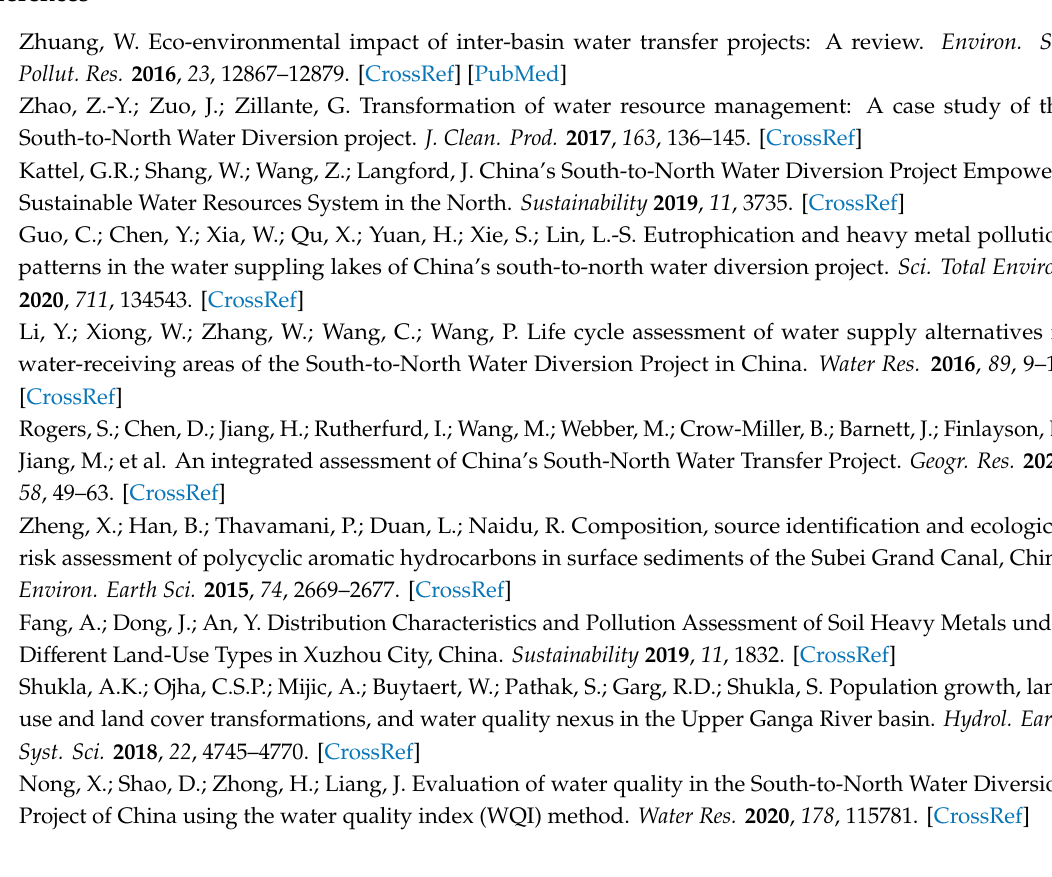
Table S1: The standard values for each class of the five main water quality parameters according to China’s Environmental Quality Standard for Surface Water (GB3838-2002). Table S2: The results of CWQII in Xuzhou section and comparison with other studies. Figure S1: Land use maps with 30 m resolution of Xuzhou City in 2005 and 2015. Figure S2: The results of the sequential Mann–Kendall test for the water quality time series in each site of Xuzhou